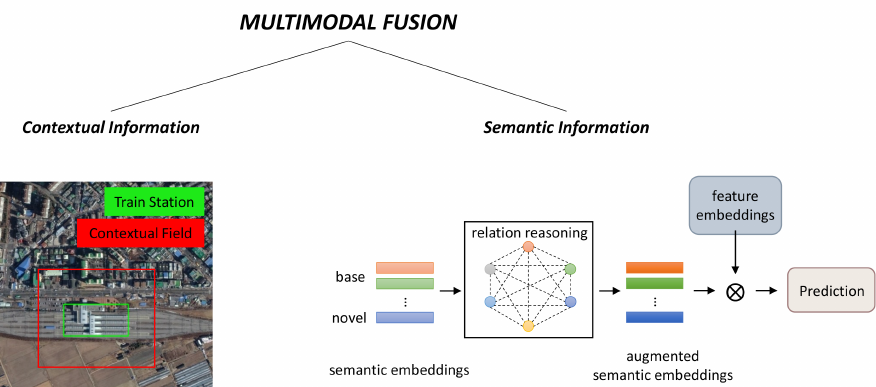
Figure 9. Principles of multi-modal fusion methods, including the introduction of contextual infor- mation and textual semantic information. Details can be found in Section